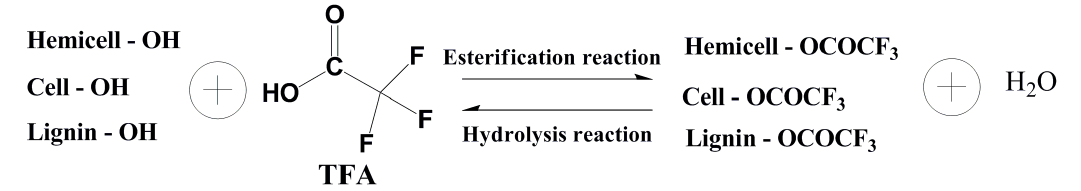
Figure 2. Reactions of esterification and hydrolysis of the lignocellulosic components.